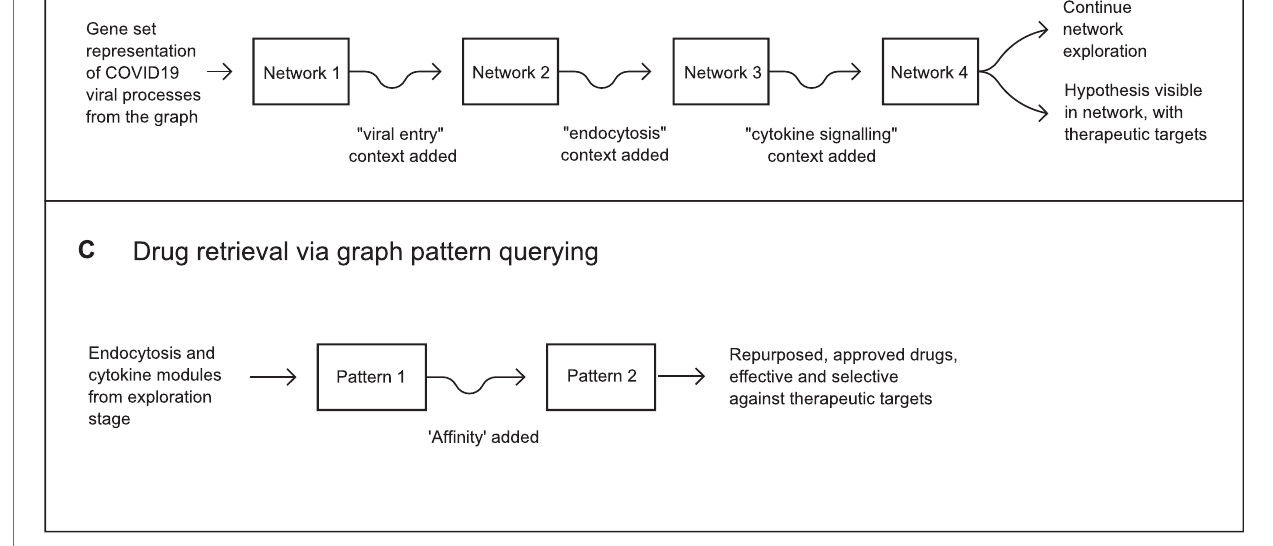
FIGURE 3 | The full drug repurposing work fl ow consisted of three stages. The fi rst stage incorporated the evaluation of a customised knowledge graph via graph patternquerying asameansofrapidqualitativeevaluation.Thesecondwasamechanisticanalysisofviralandhostprocesses, viathecreation ofaninitialnetworkusing agenesetrepresentation ofCOVID19-relatedprocessesextracted fromthecustomisedknowledgegraph.Thiswasiteratedthreemoretimestoachievea fi nalnetwork containing a clear hypothesis and therapeutic targets. The third stage resulted in a hypothesis as a partially de fi ned graph pattern, from which targets and drug candidates were retrieved, producing a fi nal set of candidate treatments for